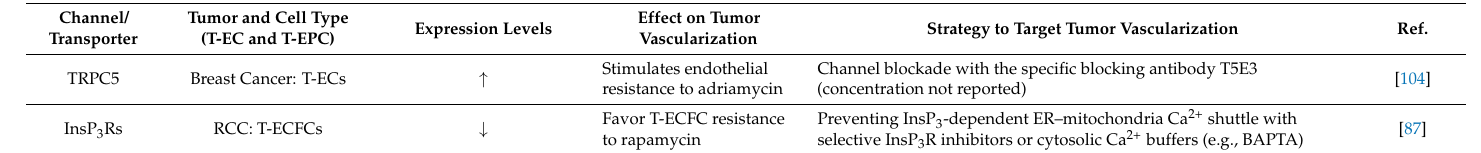
Table 2. Components of the endothelial Ca 2+ toolkit that determine endothelial cell resistance to chemotherapeutic drugs. Channel/